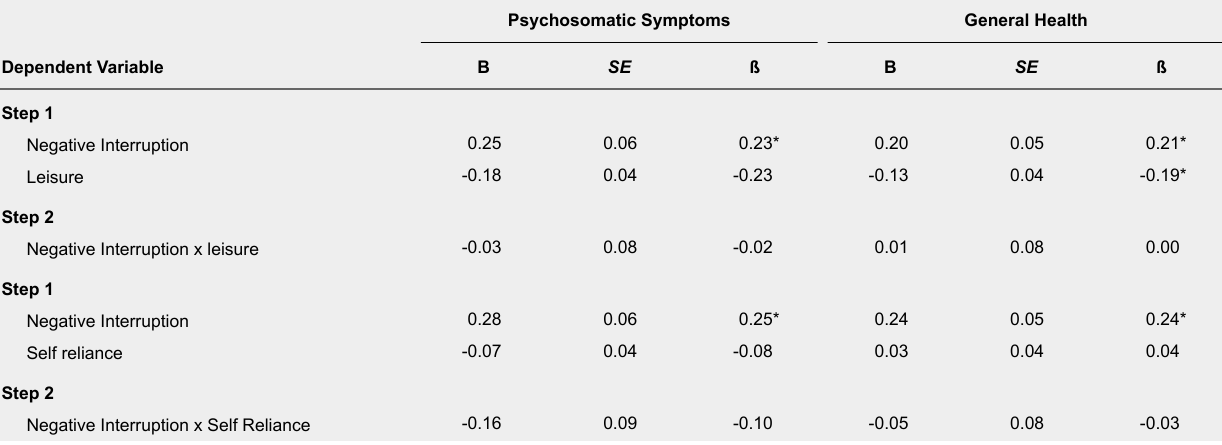
Results of Regression Analysis of Negative, Positive Interruption and Work Beliefs on Psychosomatic Symptoms and General Health